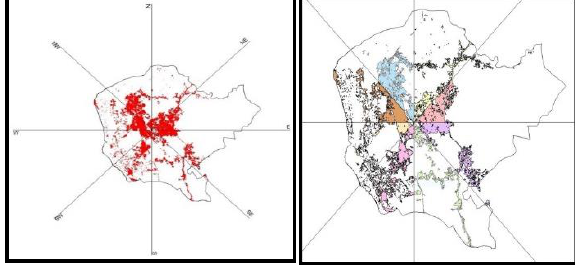
Figure 3 . Directional Division of Built-up considering built-up Centroid as the center (2019).